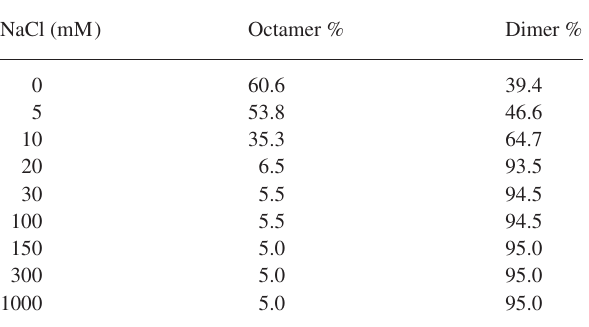
Table 1. Effect of salt concentration on the oligomer–dimer equilib- rium of the Sulfolobus solfataricus WT protein. Percentages of octamer and dimer were determined in the elution pattern from a Superdex 200 column. After exhaustive dialysis against 20 mM so- dium phosphate buffer pH 7.0, WT protein was incubated for 2 h in the same buffer containing the indicated salt concentration and imme- diately injected onto the Superdex 200 column eluted with 20 mM phosphate buffer pH 7.0 with the same salt concentration.